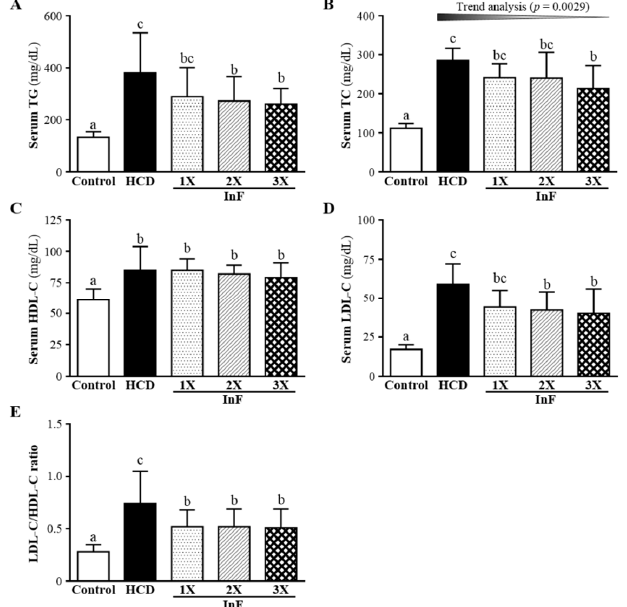
Figure 3. Effect of four-week InF supplementation on serum TC ( A ); TG ( B ); HDL-C ( C ); LDL-C ( D ) levels; and LDL-C/HDL-C ratio ( E ) in hyperlipidemic hamsters. Data are mean ± SD ( n = 8/group); values with different letters (a, b, c) differ significantly at p < 0.05 by one-way ANOVA.